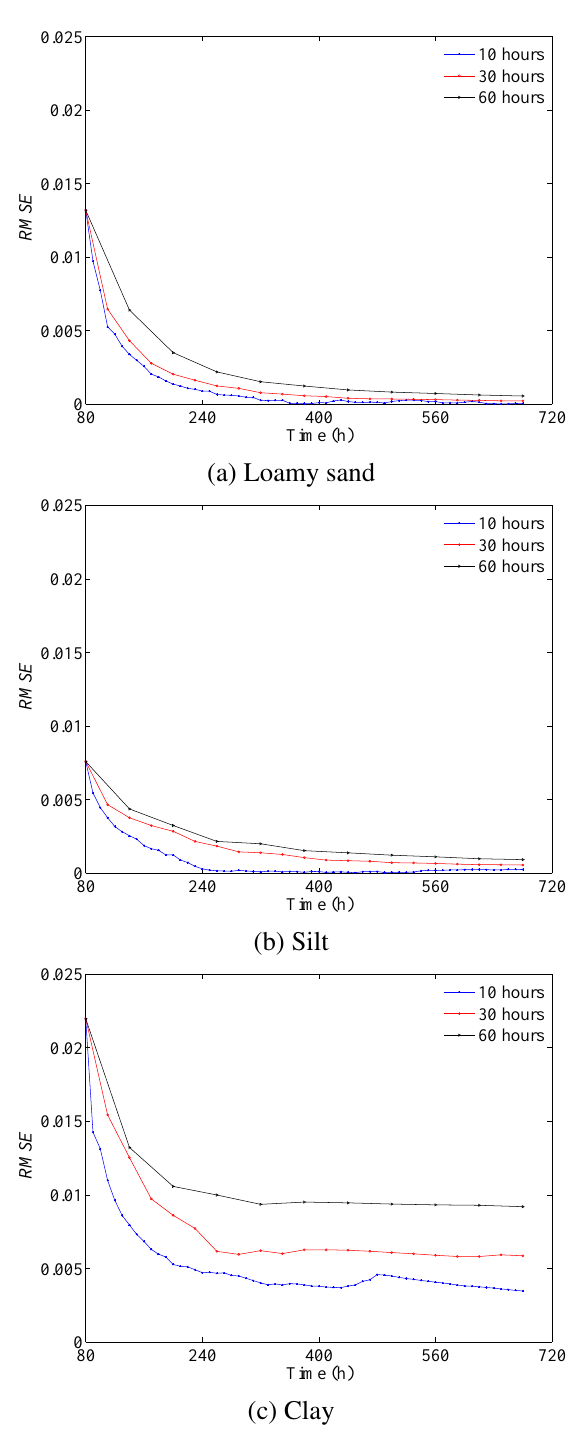
Fig. 7. The RMSE of the soil moisture profile obtained by the assimilation of GPR data with different update intervals, namely 10, 30 and 60 hours. The three soil types were compared, namely, (a) loamy sand, (b) silt and (c) clay.